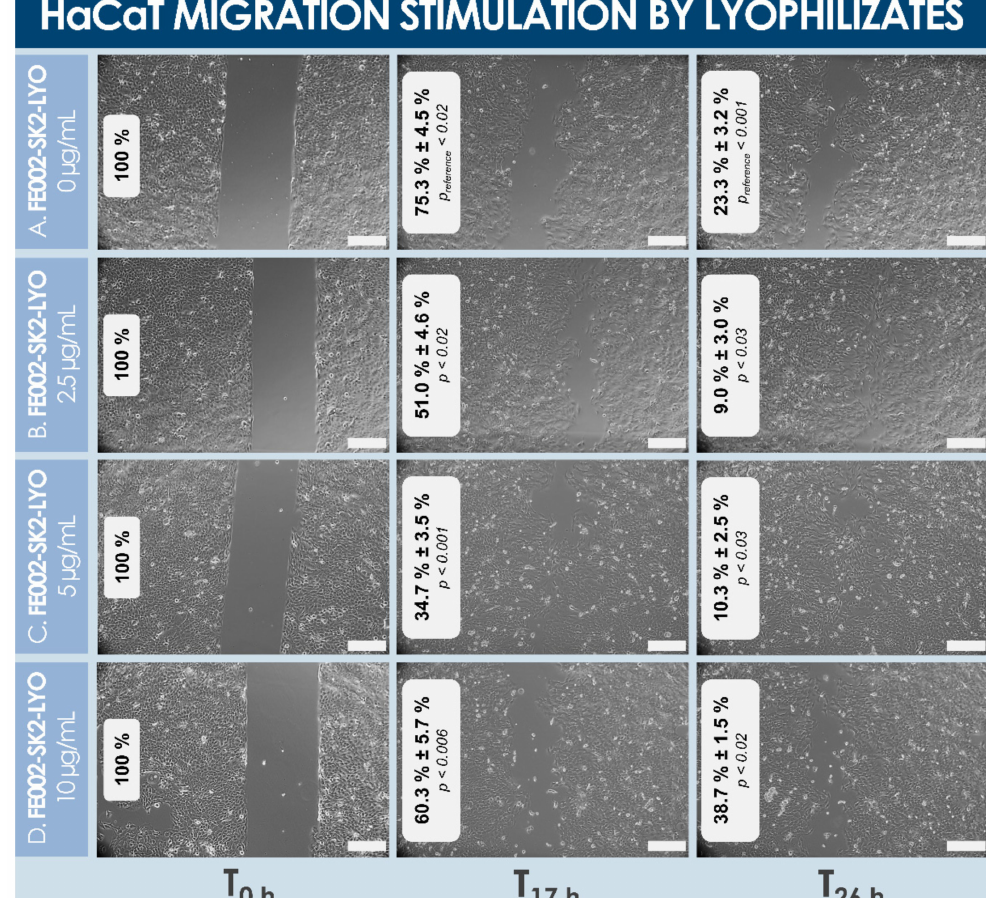
Figure 6. HaCaT cell migration stimulation potential of various doses (i.e., expressed in normalized total protein contents at the final dilution in the culture medium) of dermal FPC (e.g., FE002-SK2 cell type) lyophilizates (i.e., “LYO”, formula M). The culture medium did not contain FBS. Photographic imaging was performed at the time of treatment with the test-items, 17 h later, and 26 h later, respectively. Unpopulated culture surface areas were integrated using ImageJ. ( A ) Control group. Significant differences (i.e., p reference values < 0.05) were found in the remaining relative unpopulated surfaces at T 17 h and T 26 h as compared to T 0 h , respectively. ( B ) Lyophilizate group at a concentration of 2.5 µ g/mL. ( C ) Lyophilizate group at a concentration of 5 µ g/mL. ( D ) Lyophilizate group at a concentration of 10 µ g/mL. Quantitative assessment of remaining relative unpopulated culture surfaces indicated a positive effect of lyophilizates on keratinocyte migration at two investigated doses (i.e., 2.5 and 5 µ g/mL), as compared to controls. Higher doses (i.e., 10 µ g/mL) of lyophilizate promoted cell migration at T 17 h , as compared to controls, but hindered cell migration at the T 26 h timepoint, as compared to controls. At both timepoints and at all treatment concentrations, statistically significative differences (i.e., p < 0.05) were found for remaining unpopulated surface values, as compared to corresponding values from the control group (i.e., no treatment). Scale bars = 200 µ m. FBS, fetal bovine serum; FPC, fibroblast progenitor